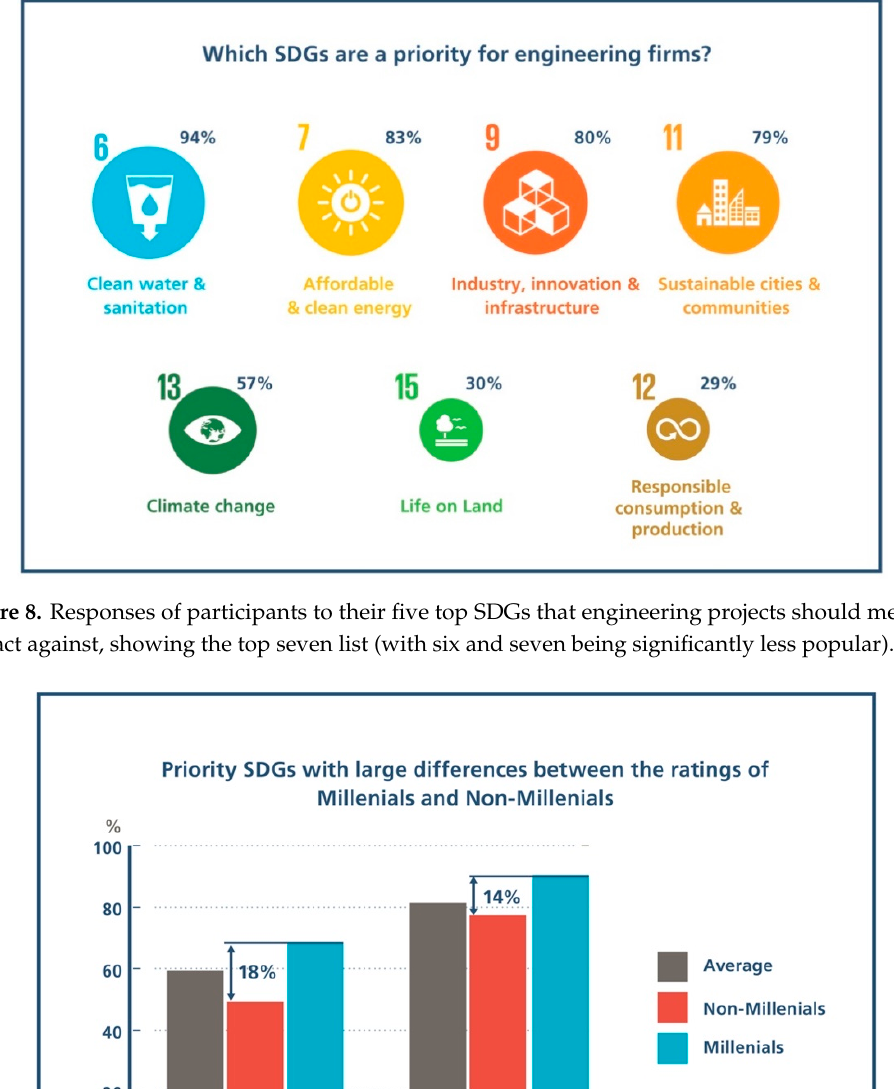
Figure 9. Preference of the SDGs 13 and 15; differentiating between millennials.